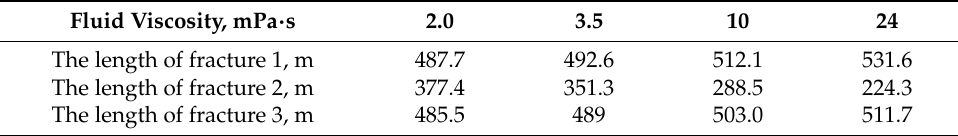
Figure 8. Effect of fluid viscosity on the fracture geometry: ( a ) 2 mPa · s; ( b ) 3.5 mPa · s; ( c ) 10 mPa · s; and ( d ) 24 mPa · s. Table 5. The results of fracture length affected by different fluid viscosities.